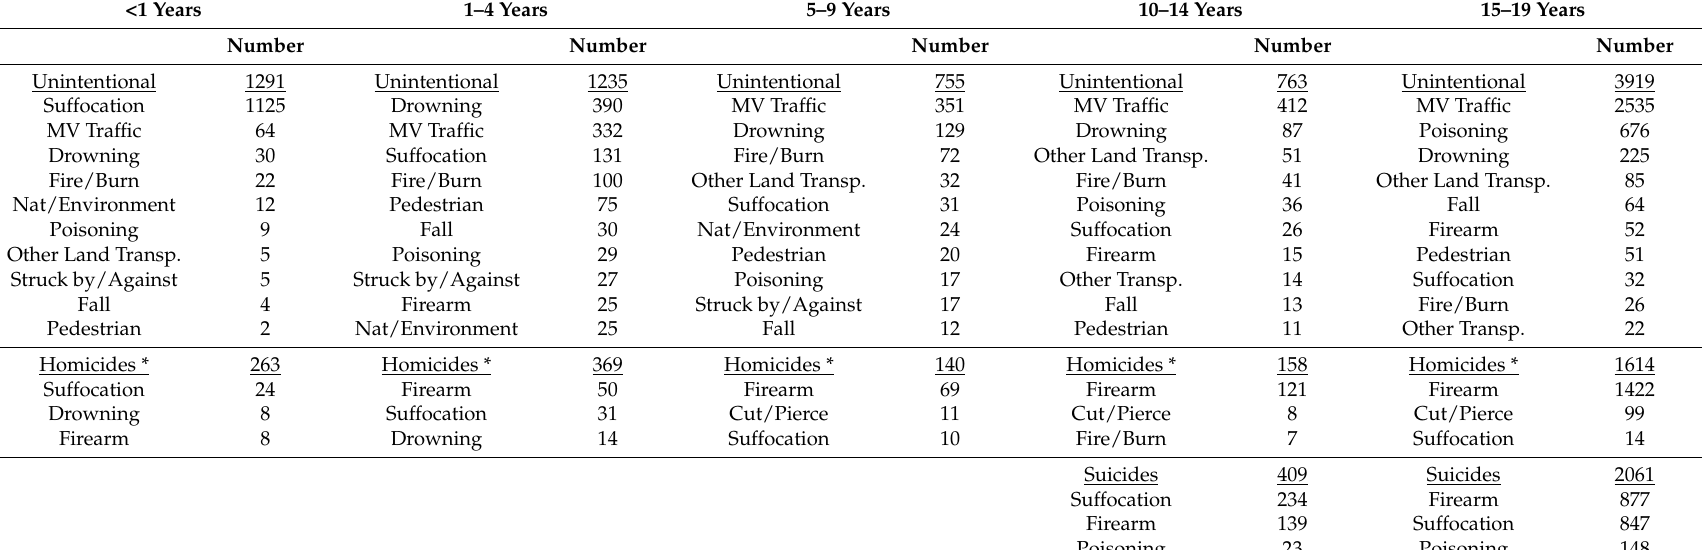
Transp = transportation; Nat = natural. * Includes legal intervention and terrorism, but excludes operations of